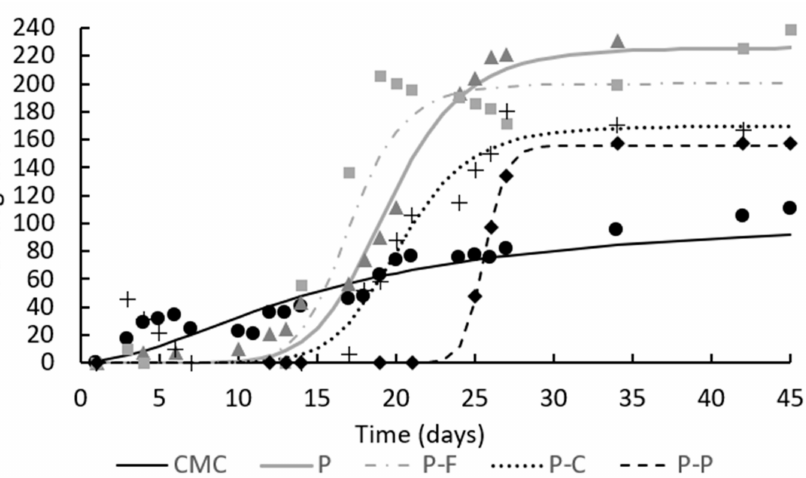
Figure 4. Biodegradation kinetics of CMC ( ) and PLA-PHBV films P ( ), PLA-PHBV films con- taining ferulic acid P-F ( ), p -coumaric acid P-C ( + ) and protocatechuic acid P-P ( ) throughout the composting time. Experimental data (symbols) and Hill’s fitted model